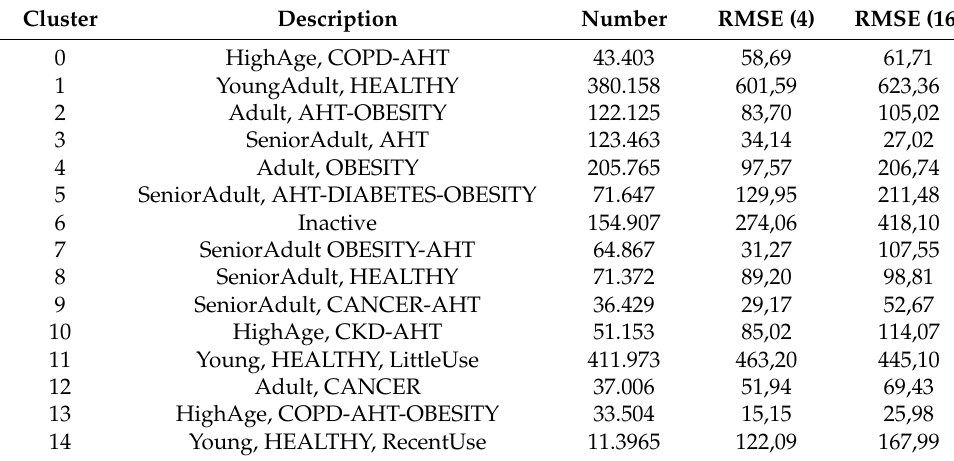
Table 9. Result for clusters with different RSMEs.